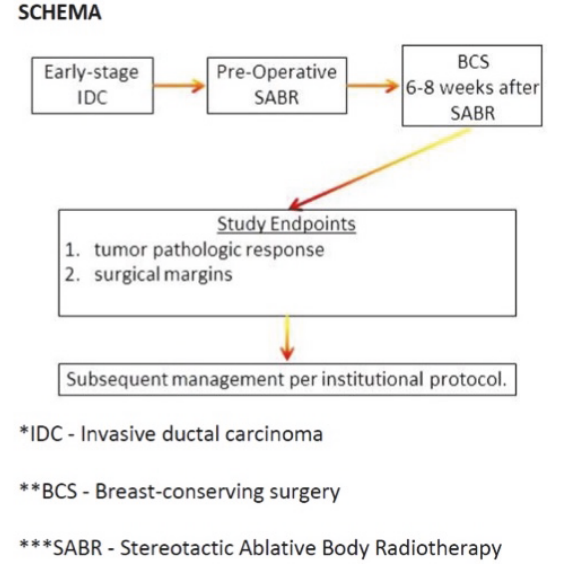
Figure 1: Trial schema for preoperative stereotactic radiation